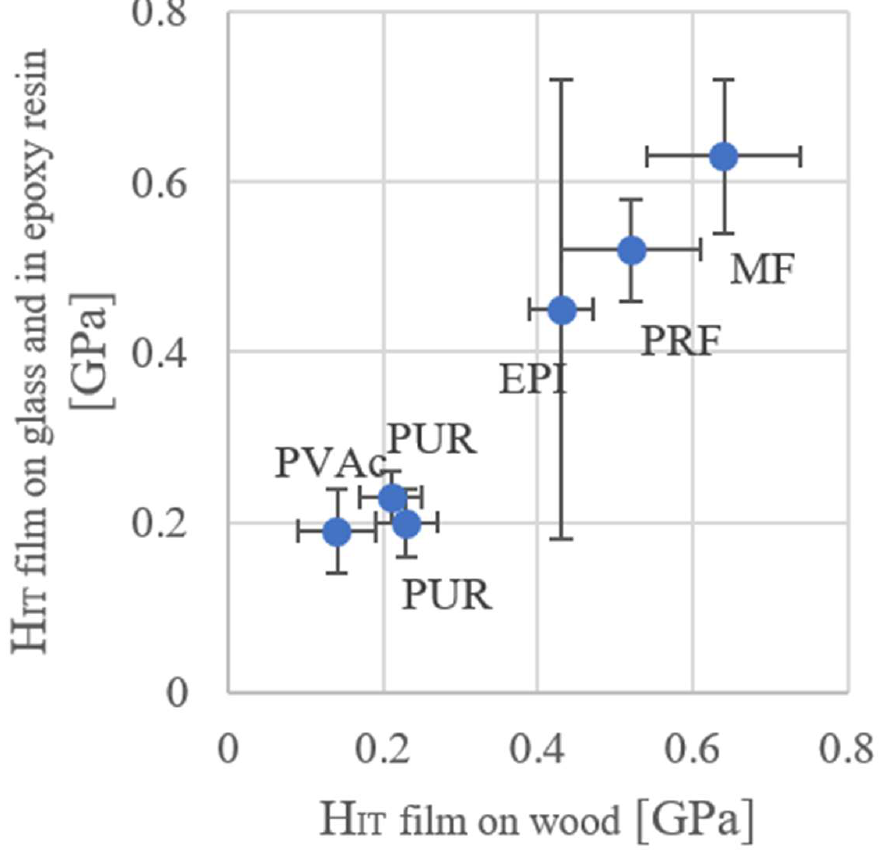
Figure 5. Comparison of the hardness from the nanoindentation of the pure polymer films and polymers in the adhesive on the wood (error bars correspond to the standard deviation).